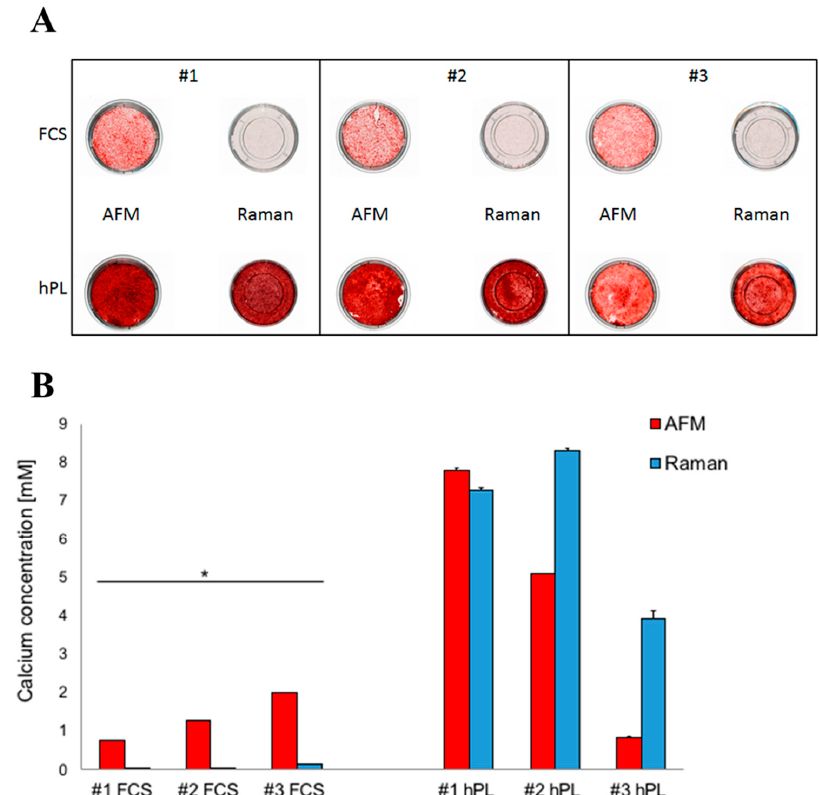
Figure 2. Detection of JPCs mineralization (Alizarin Red staining) in AFM and Raman petri dishes under FCS and hPL supplementation. Macroscopic images: JPC mineralization from three donors (#1, #2, #3) cultured in AFM (plastic bottom) and Raman (glass bottom) petri dishes was observed after osteogenic induction for 25 days under both medium supplementations ( A ). Quantification of JPC mineralization degrees in cell monolayers from the three donors ( B ). Calcium levels detected in cell monolayers cultured in AFM dishes are represented by red columns and those in Raman petri dishes by blue columns. Abbreviations: AFM—atomic force microscopy, FCS—fetal calf serum, hPL—human platelet lysate, * p < 0.05.